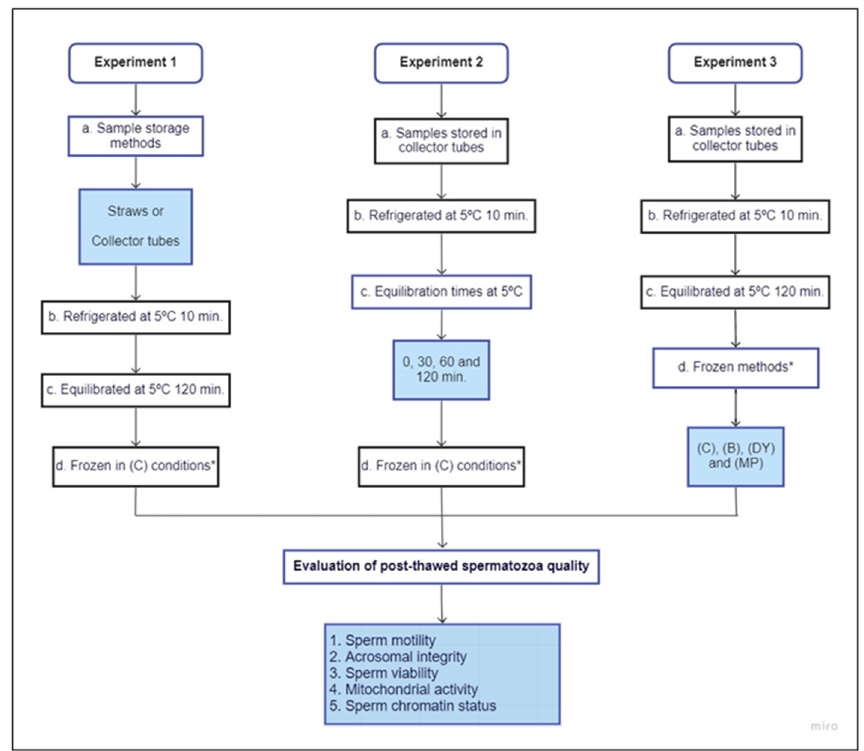
Figure 1. Experimental design: (C) control—samples frozen in liquid nitrogen vapors in tank;